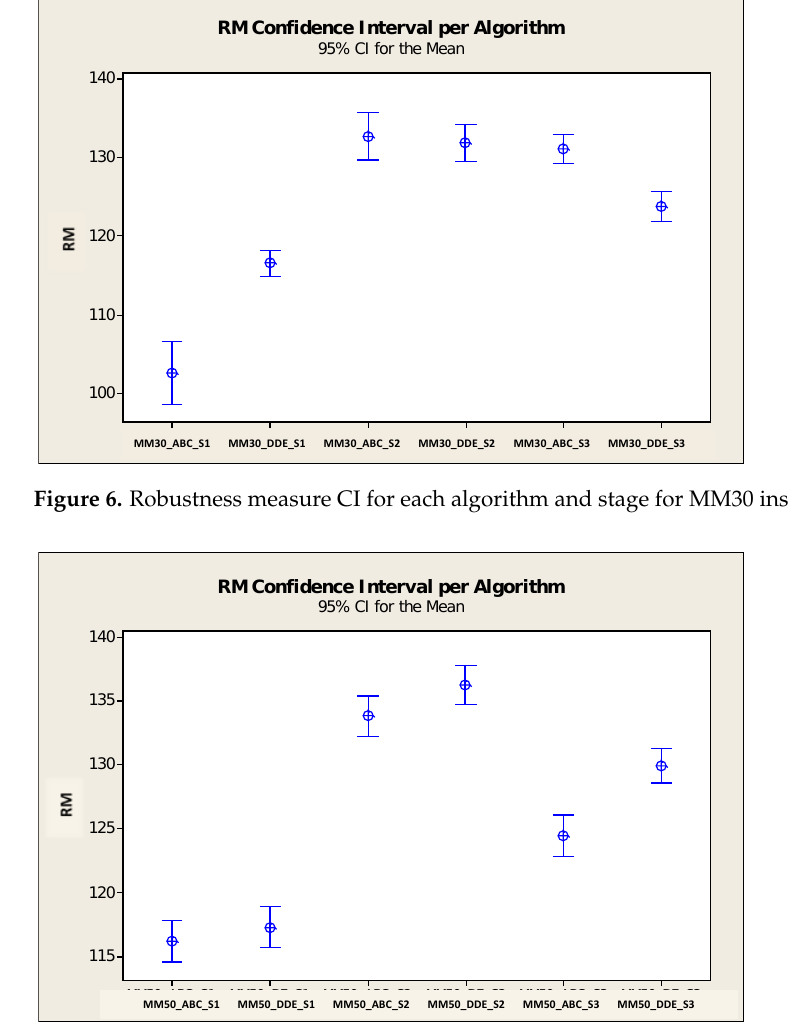
Figure 7. Robustness measure CI for each algorithm and stage for MM50 instances.